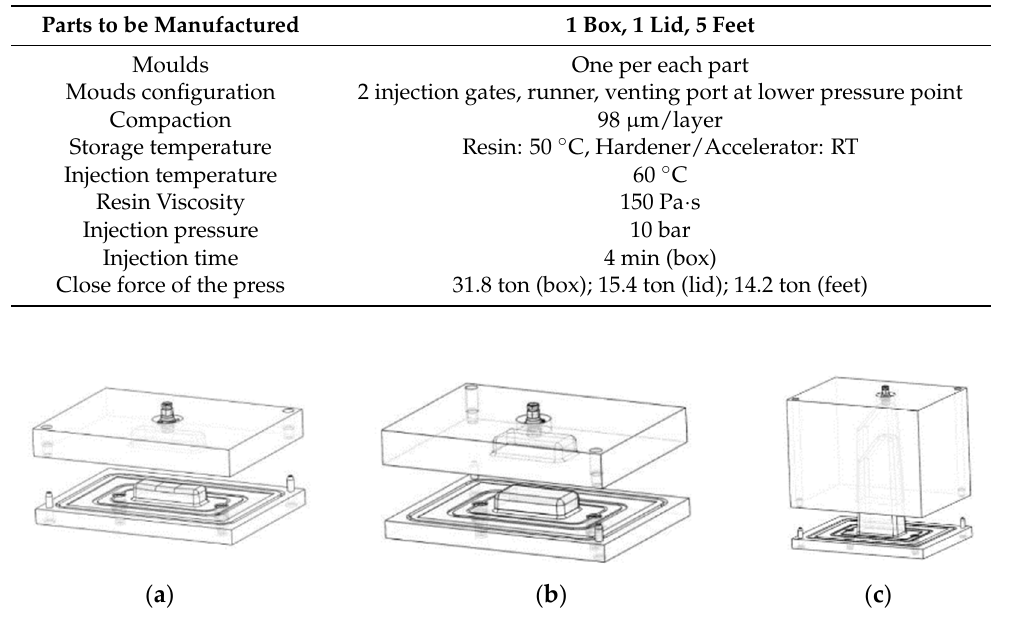
Table 17. Manufacturing conditions of the electronic box.